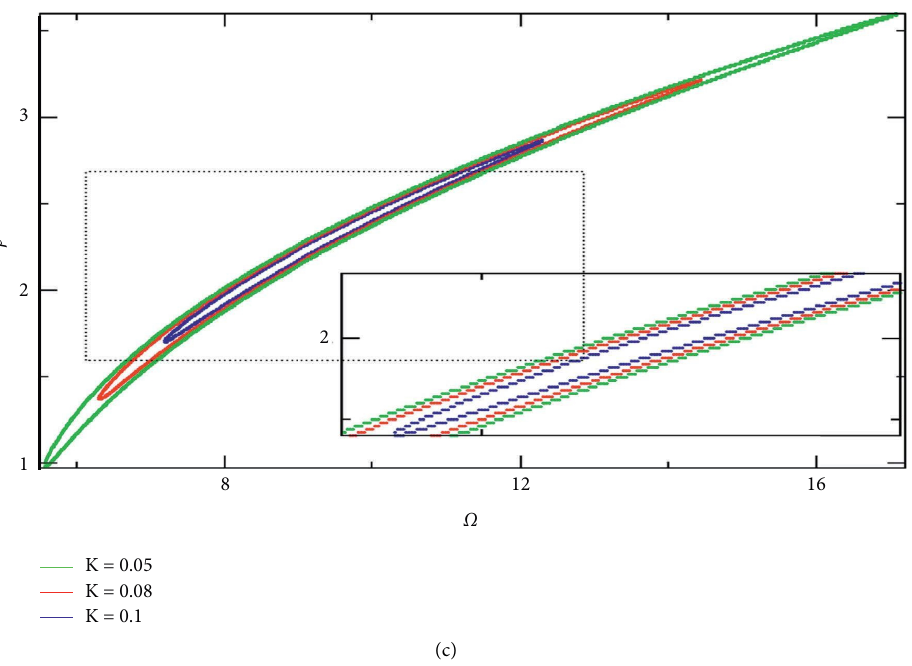
� 4 . 89 ; μ � 8 . 5 ; λ � 1 . 7625 ; M � 0 . 1 ; g � 10 ; C 0